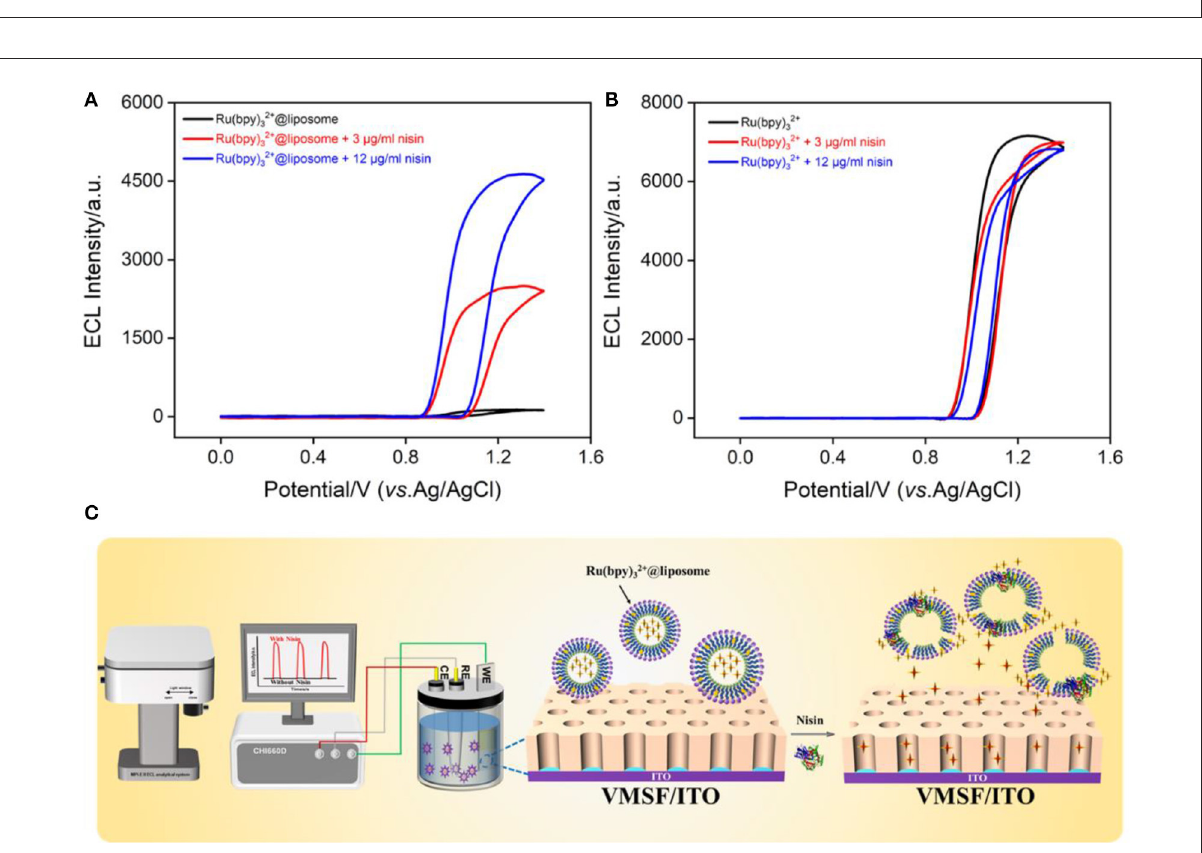
FIGURE5 ECL signal-potential curves obtained before and after adding different concentrations of nisin to Ru(bpy) 32 + @liposome (A) or Ru(bpy) 32 + (B) . The PMT voltage is 650V (A) or 400V (B) , respectively. (C) The illustration of ECL determination of nisin based on the release of Ru(bpy) 32 + resulting from the interaction between nisin and